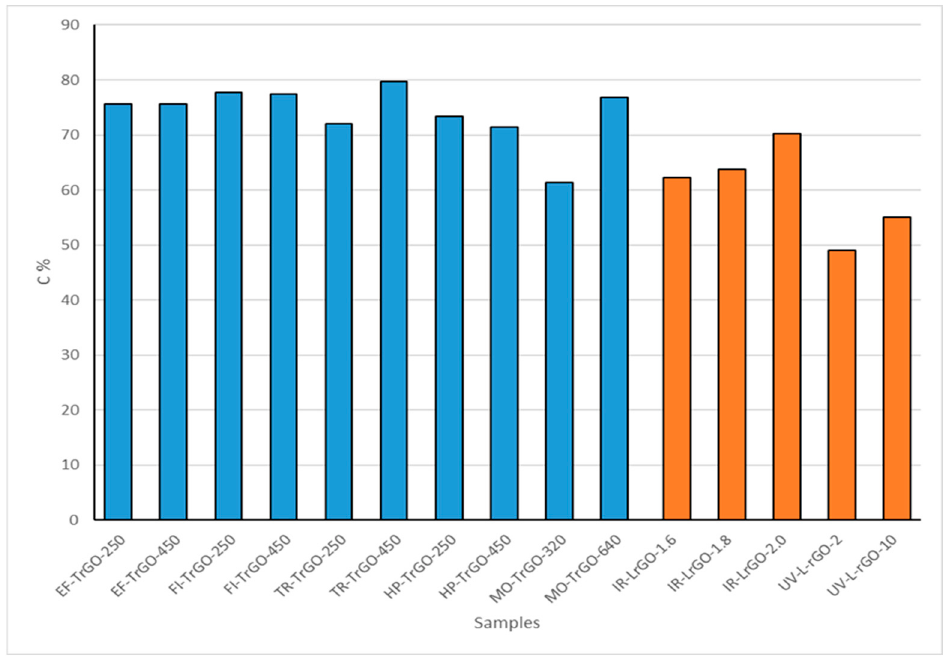
Figure 4. Carbon concentrations for TrGO and LrGO samples.